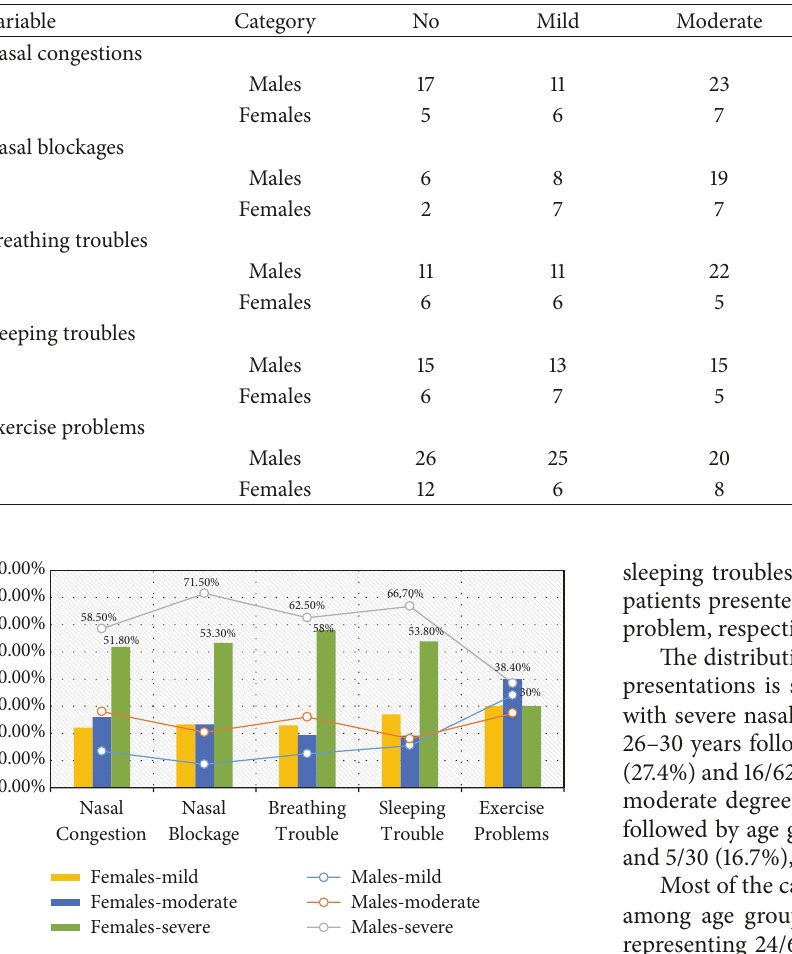
Figure4:Descriptionofpatientsbyinitialclinicalpresentationsand